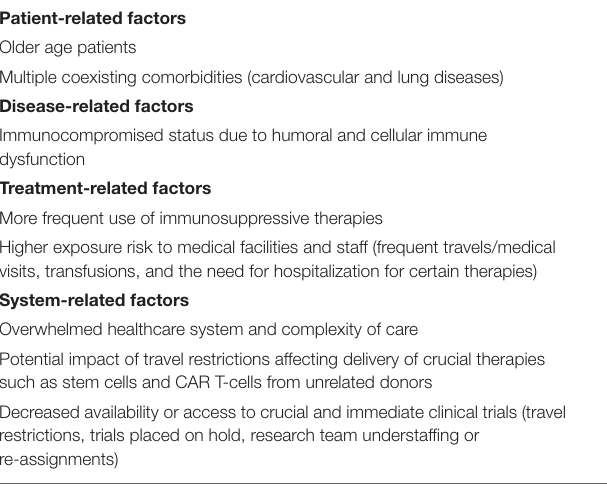
TABLE 1 | Unique considerations for COVID-19 in patients with hematologic malignancies. Patient-related